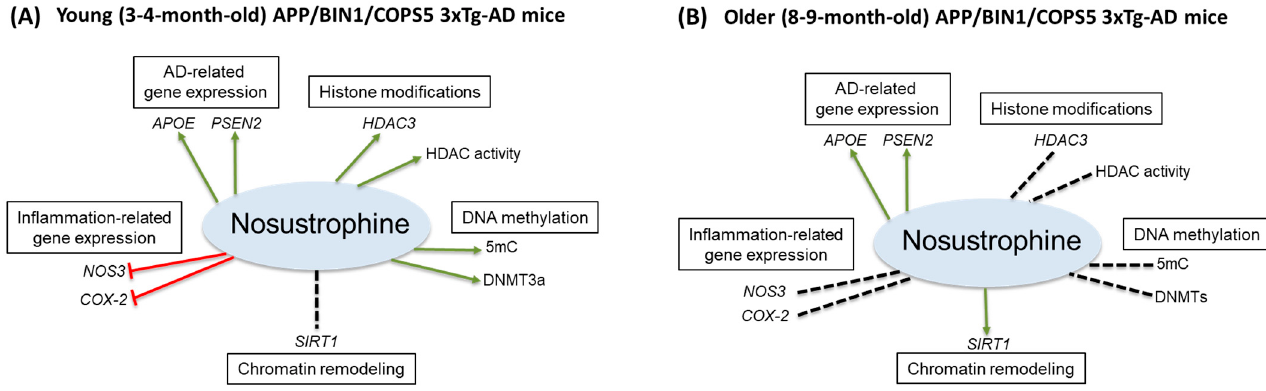
Figure 12. Pharmacoepigenetic actions of Nosustrophine in the hippocampus of triple-transgenic AD mice. Nosustrophine regulates AD-related APOE and PSEN2 gene expression in ( A ) young and ( B ) older APP/BIN1/COPS5 3xTg-AD mice, inflammation-related ( NOS3 and COX-2 ) gene expression in 3–4-month-old mice only, global (5mC)- and de novo, DNA methylation ( DNMT3a ), HDAC3 expression and HDAC activity in 3–4-month-old mice; and SIRT1 expression in 8–9-month-old mice. Nosustrophine appears to be effective earlier in the AD continuum ( A ) and may be beneficial as a primary- (prior to the appearance of AD biomarkers) and/or secondary (AD biomarker-positive, but cognitively asymptomatic) interventional treatment against AD by targeting neuroinflammation and the epigenetic apparatus. Note that in older mice ( B ) Nosustrophine promotes SIRT1 expression; SIRT1 overexpression may regulate neurodegeneration ( β -amyloid and tau pathology) possibly via histone H3 deacetylation, mitochondrial dysfunction, and APP processing in AD. 3xTg-AD, triple-transgenic mouse model of AD; 5-methylcytosine, 5mC; AD, Alzheimer’s disease; APOE, apolipoprotein E; APP, amyloid precursor protein; COX-2, cyclooxygenase-2; DNA methyltransferase 3a, DNMT3a; HDAC, histone deacetylase; NOS3, nitric oxide synthase 3; PSEN2, presenilin 2; SIRT1, Sirtuin 1. Red line, inhibitory; green arrowed line, stimulatory; stippled black line, no effect. Neuroinflammation is critical to AD pathogenesis and its progression. IL-1 β and IL- NOS3 overexpression promotes apoptosis and COX-2 is a key mediator of